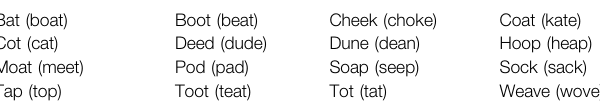
TABLE 1| Targetwords and their (minimal pairs)used inthe experiment